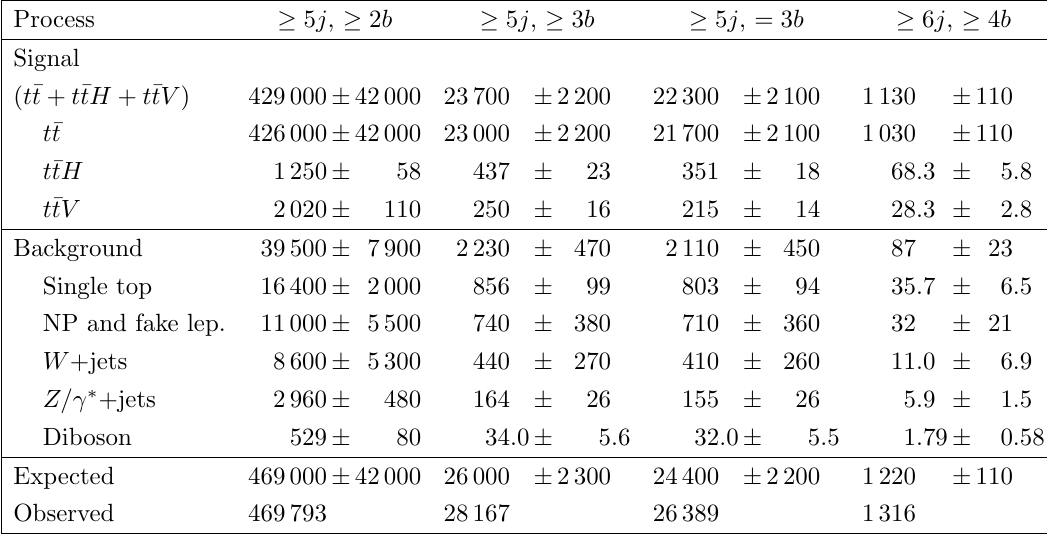
Table 3. Predicted and observed lepton+jets event yields in the (cid:21) 5 j (cid:21) 2 b , (cid:21) 5 j (cid:21) 3 b , (cid:21) 5 j = 3 b , and (cid:21) 6 j (cid:21) 4 b selections. The quoted uncertainties are symmetrised and indicate total statistical and systematic uncertainties in predictions due to experimental